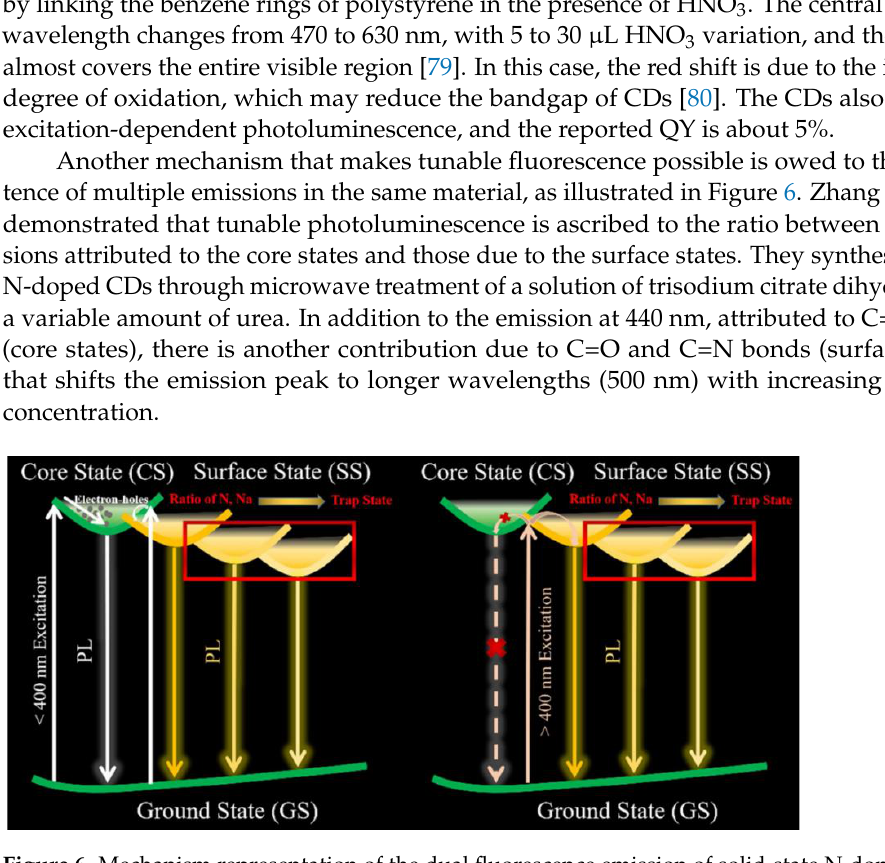
Figure 5. Photograph of the conventional CDs ( 1 , 4 ), trisodium citrate dihydrate ( 2 , 5 ), and NCD11 powders ( 3 , 6 ) under daylight ( upper row ) and 365 nm UV lamp ( bottom row ). (Reprinted from [78]; with the permission of Elsevier).